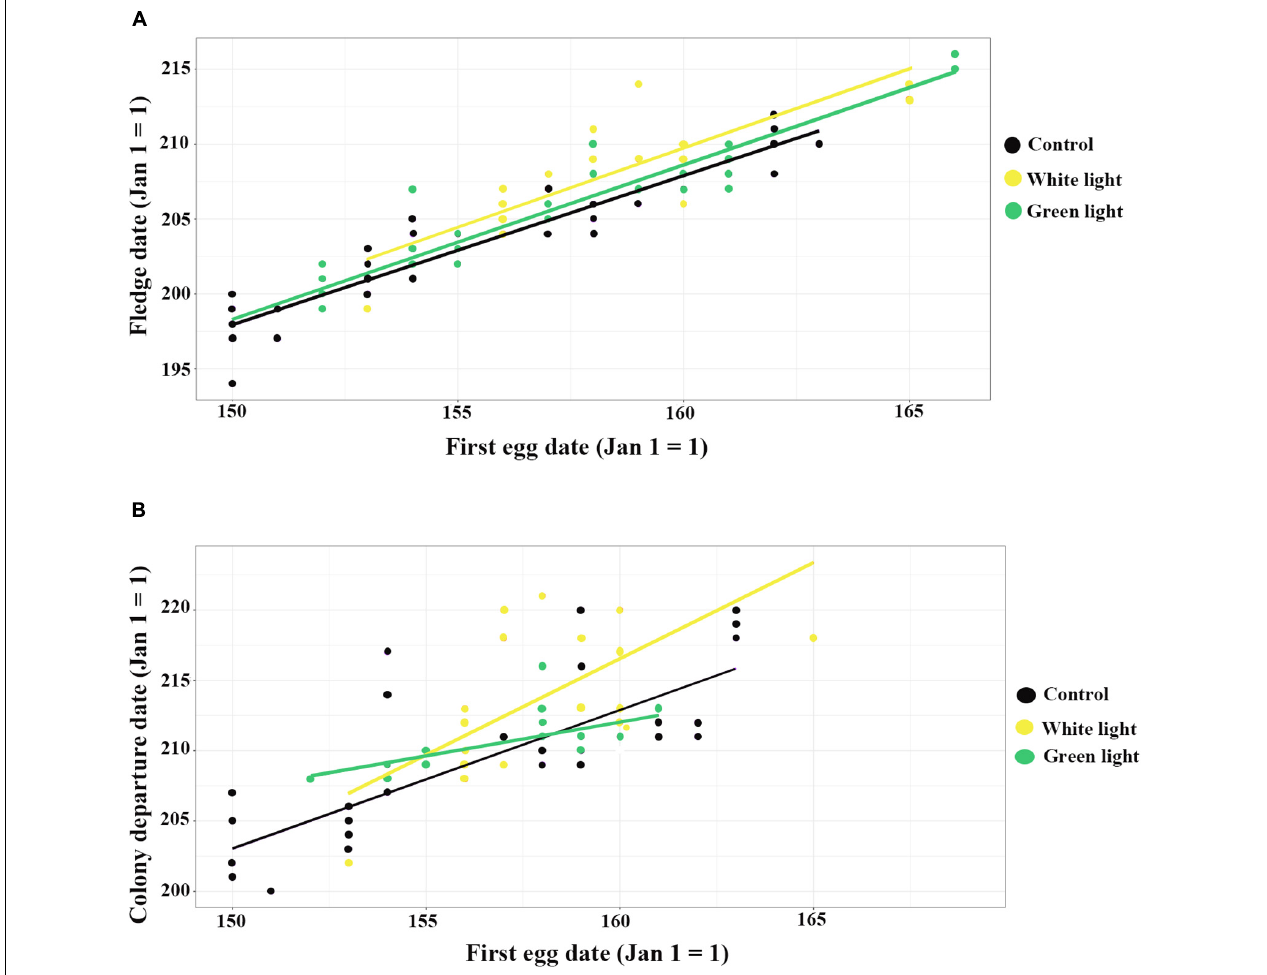
FIGURE 1 | The influence of ALAN (white and green lights) on fledge date and colony departure date, (A) shows the correlation between first egg date and fledge date; (B) shows the correlation between first egg date and colony departure date. Yellow = white light, Green: green light, and Black =